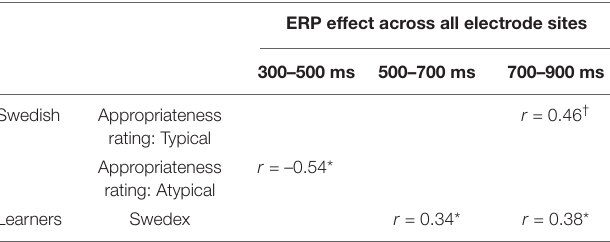
TABLE 6 | Correlations amplitude of ERP effects with appropriateness